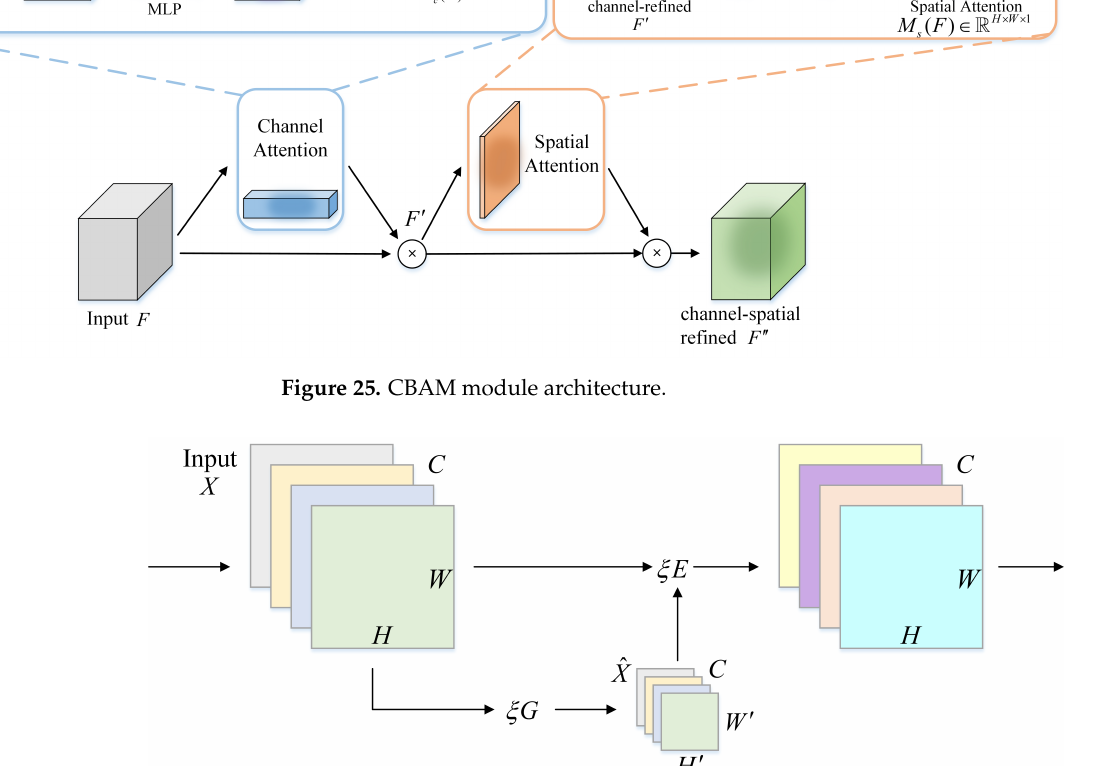
Figure 26. Gather-Excite